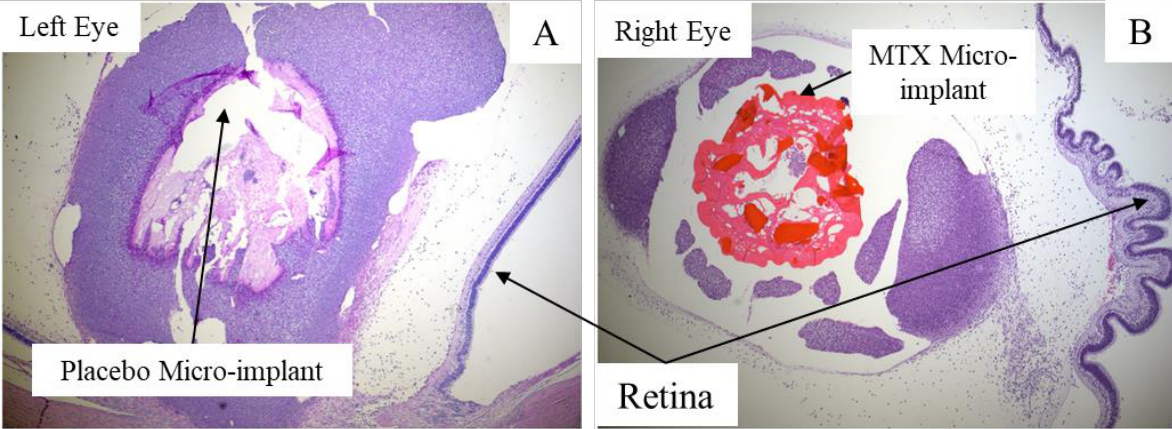
Figure 5. Histopathology findings using H&E staining. ( A ) microslide (4 × shows the placebo micro-implant (Day 28) surrounded by a more pronounced inflammatory capsule; ( B ) microslide (4 × ) shows the MTX micro-implant (Day 28) with mild non-granulomatous inflammatory infiltrate surrounding the micro-implant and localized vitreous traction causing wrinkling of the retina. The retina appears anatomically healthy.